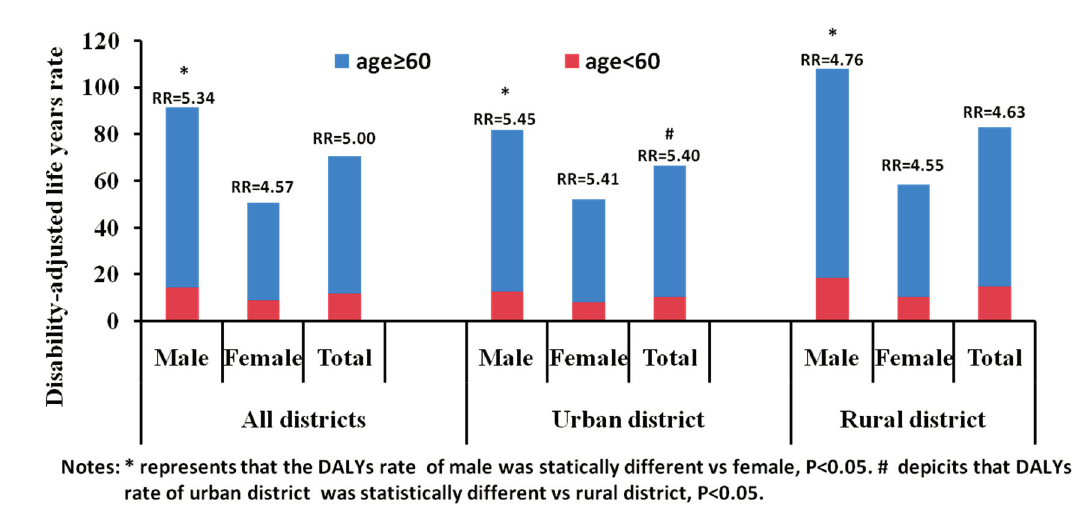
Figure 6. Disability-adjusted life years rate for the elderly ( ≥ 60 years) and young (<60 years) populations in China, 2005–2011.